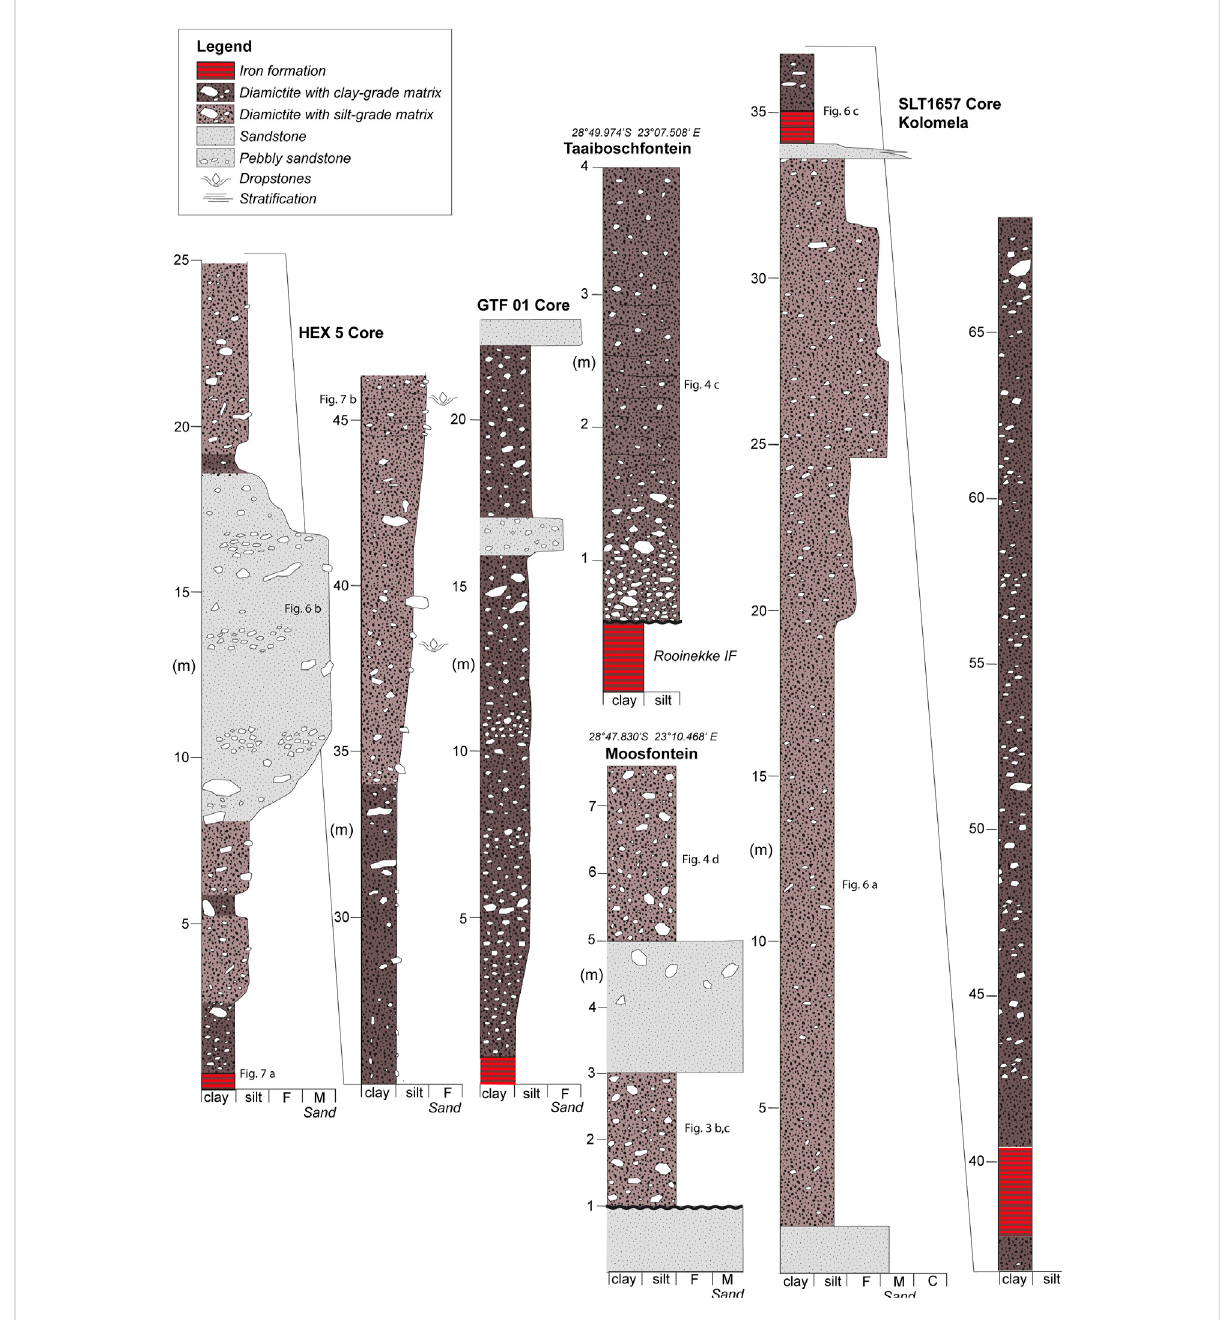
FIGURE 3 SedimentarylogsoftheMakganyeneFormation,drawnfrombothshallowsubsurfaceboreholes(HEX5,GTF01andSLT1657)andfromoutcrop (TaaiboschfonteinandMoosfontein)outcrops.FurtheroutcropobservationsmadeataroadsidesectionPostmasburgandKimberley(seeFigure1for location) are also included in this paper, but the section only exposed 3 m of stratigraphy and was not